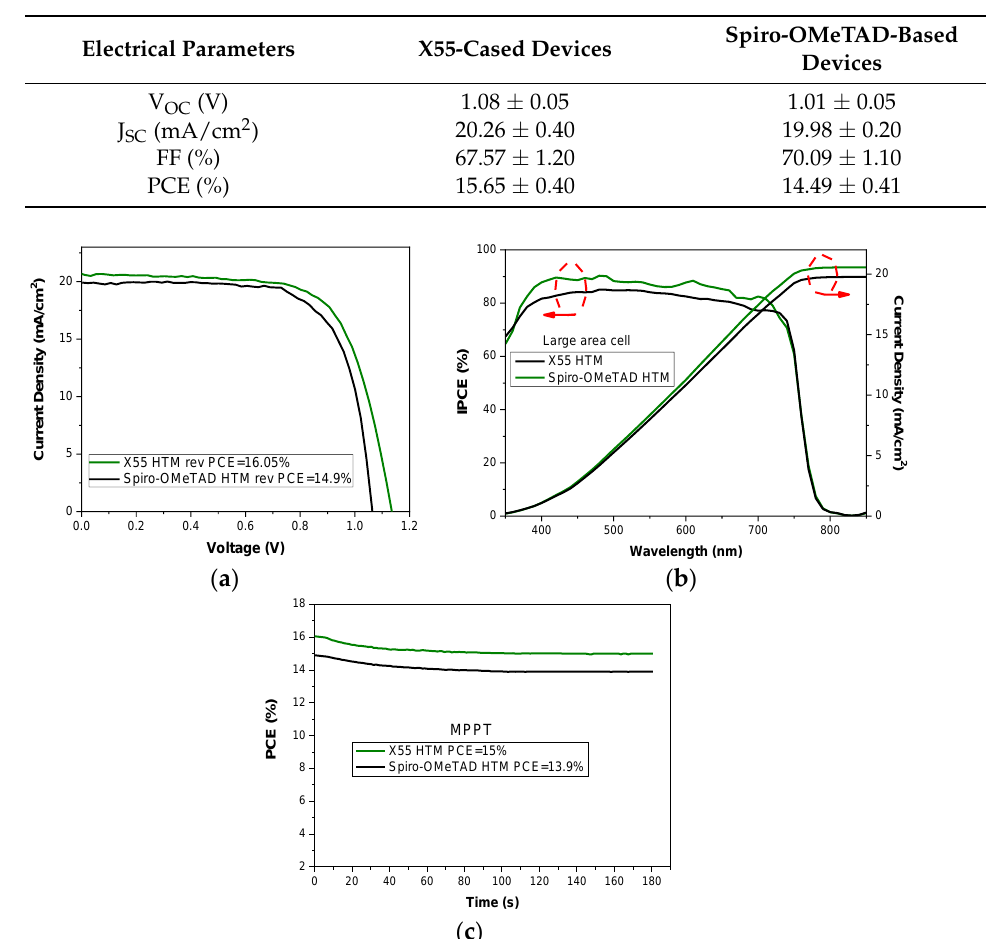
Figure 5. ( a ) JV curves of the best large area cells and ( b ) corresponding IPCE. ( c ) MPP tracking. The current density is about 20 mA/cm 2 , as reported in the IPCE spectra (Figure 5b). The best efficiencies are 16.05% (15% stabilized at MPP) and 14.9% (13.9% stabilized